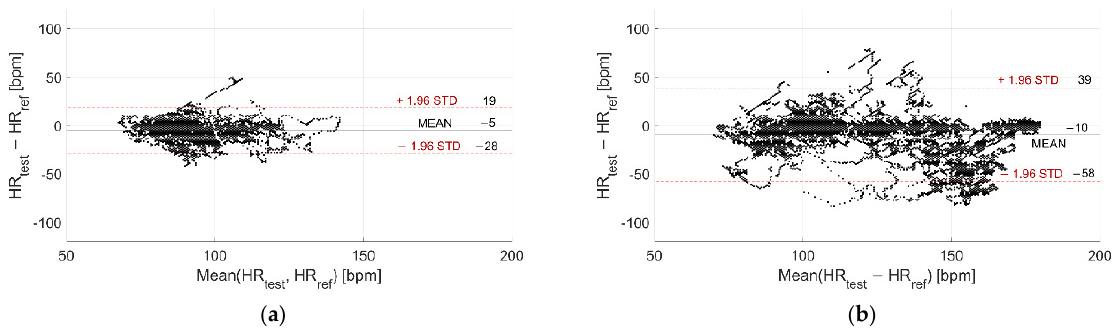
Figure 12. Bland–Altman plot related to recordings performed ( a ) Resting and ( b ) During activities, including recordings both at in-water and dry conditions performed with Polar Vantage V2 (reference instrument: Polar H10.